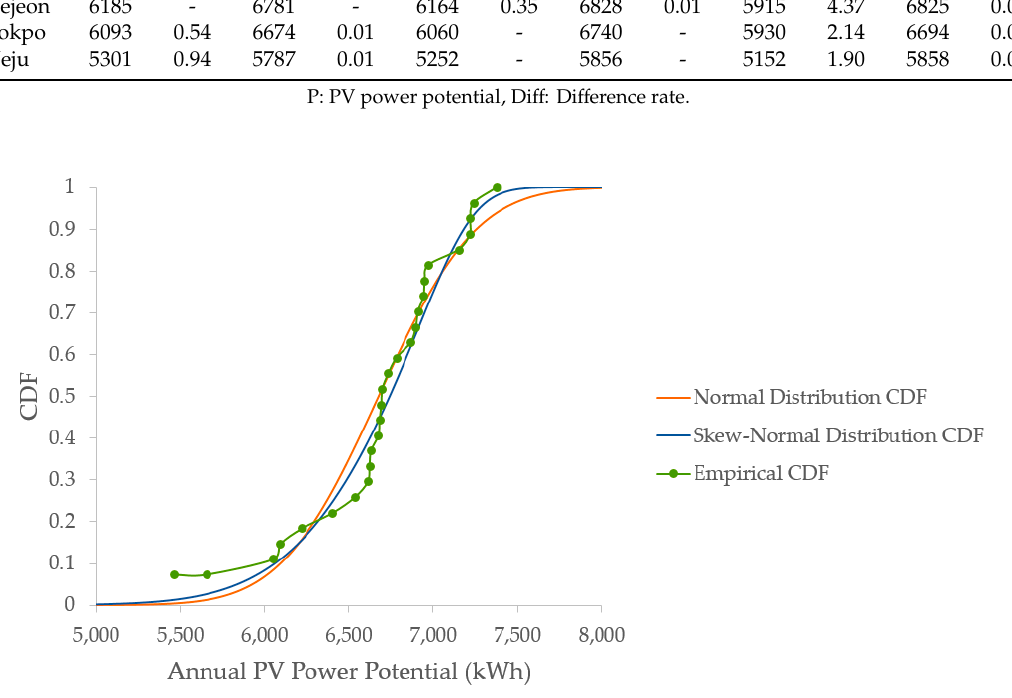
Figure 7. CDF of the three distributions in Mokpo.